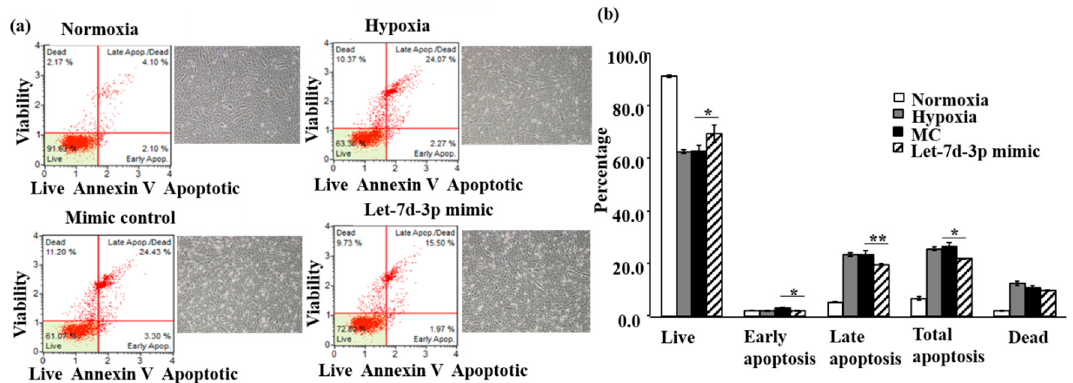
Figure 2. The protective effect Let-7d-3p is via the inhibition of apoptosis. With Annexin V/7-AAD double staining, Let-7d-3p increased live cells and decreased early and late apoptosis and total apoptosis cells in H9c2 subjected to hypoxia challenge. Results are shown in ( a ) Annexin-V MUSE cell analysis and morphology; ( b ) The percentage of cells in live, early apoptosis, late apoptosis, total apoptosis, and dead respectively. Experiments were repeated twice in triplicate, Data are presented as Mean ± SD with Student’s t-test, * p < 0.05, ** p < 0.01.